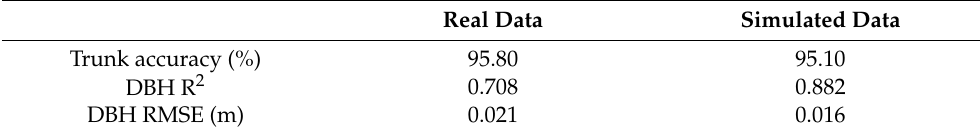
Table 4. The accuracies of trunk point extraction and DBH measurement.